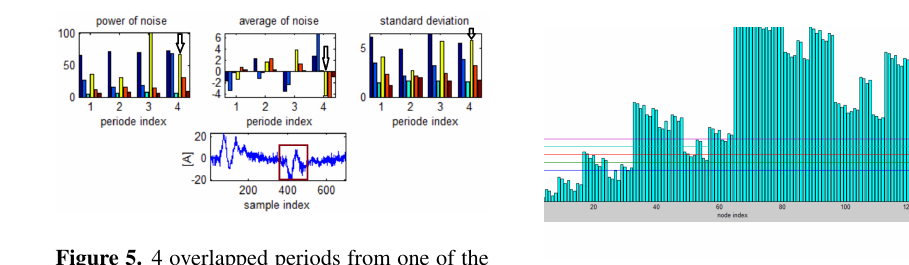
Figure 6. Lowest significant harmonic orders in WPT